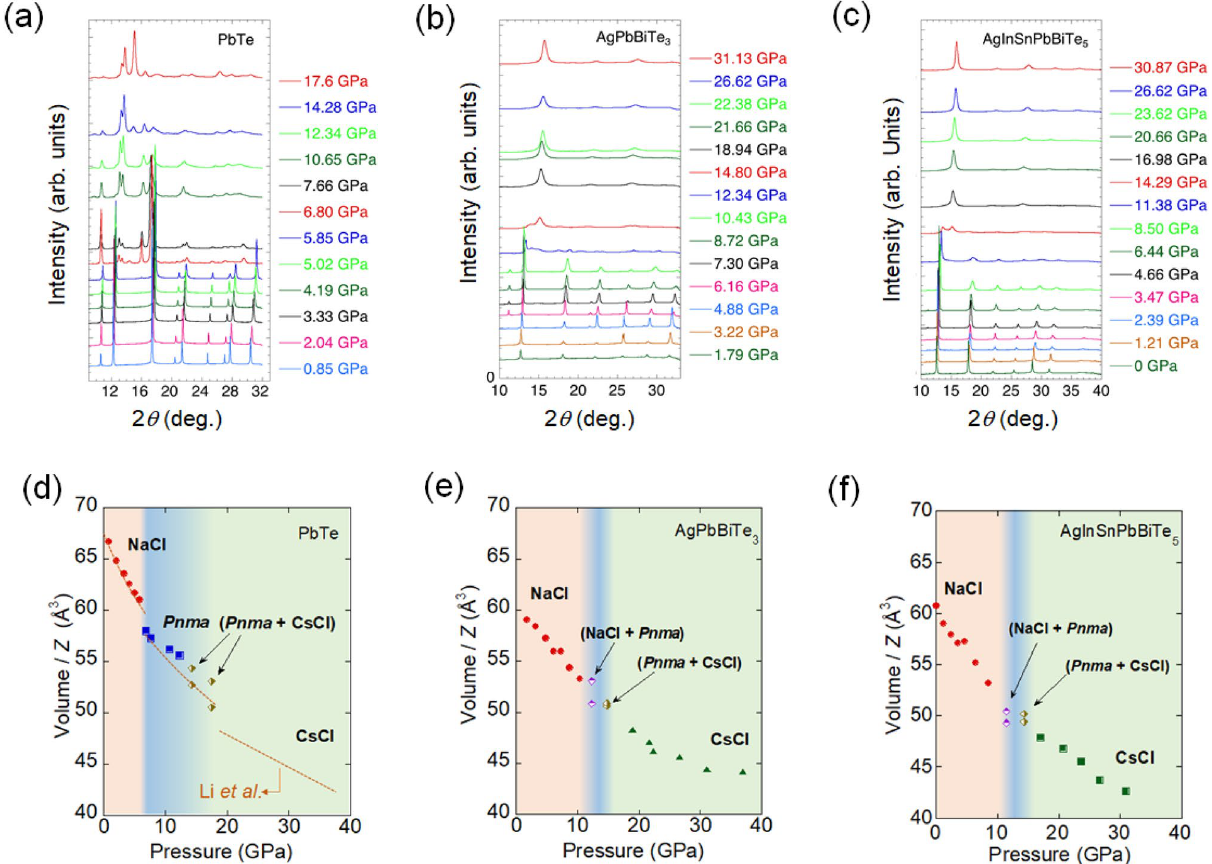
Figure 3. Pressure evolutions of crystal structure for metal tellurides with different configurational entropy of mixing. ( a – c ) SXRD patterns for PbTe, AgPbBiTe 3 , and AgInSnPbBiTe 5 . Note that the baseline height of the XRD pattern at each pressure scales to the pressure. ( d–f ) Lattice volumes divided by Z (chemical formula sum in a unit cell) for PbTe, AgPbBiTe 3 , and AgInSnPbBiTe 5 are plotted as a function of pressure. In ( d ), the analysis results reported in Ref. 24 (Li et al . ) are represented by orange lines. Structural types are shown in the